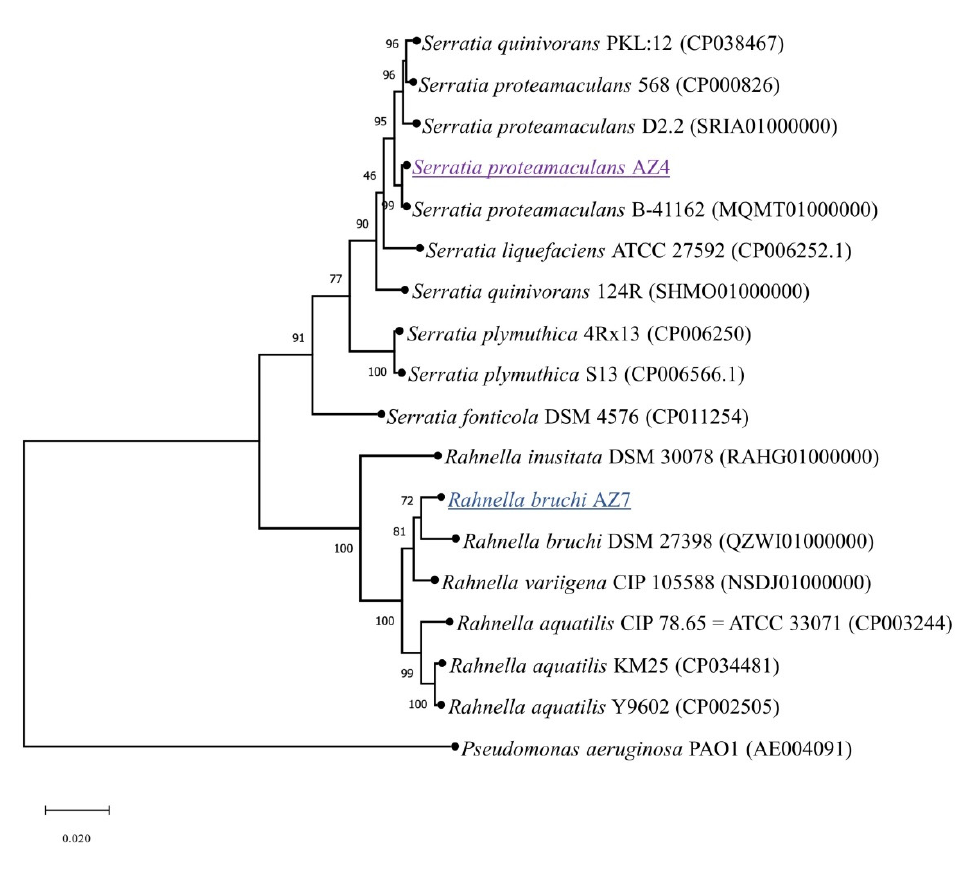
Figure 8. Changes in the optical density (OD 600 ) and degradation of DCF by S. proteamaculans AS4 and R. bruchi AS7 under co-metabolic conditions with glucose (1 g L − 1 ). The data are presented as the mean values of three biological replicates ± standard deviation.